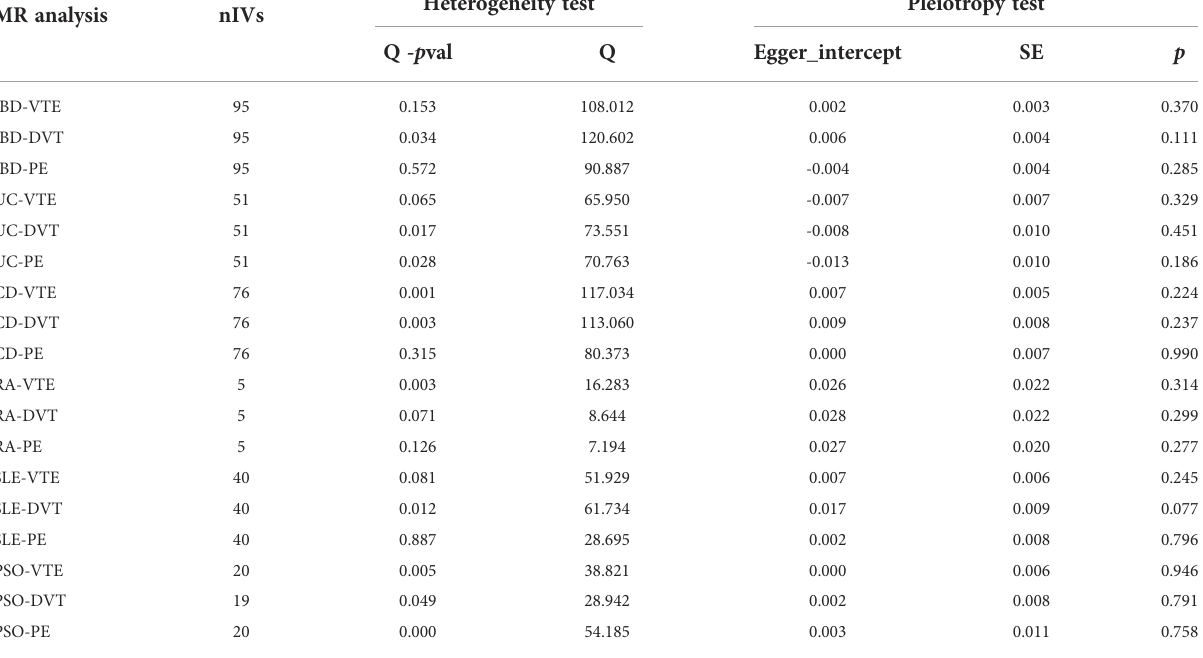
TABLE 2 Heterogeneity and pleiotropy tests for the associations between IMIDs with VTE/DVT/PE. MR